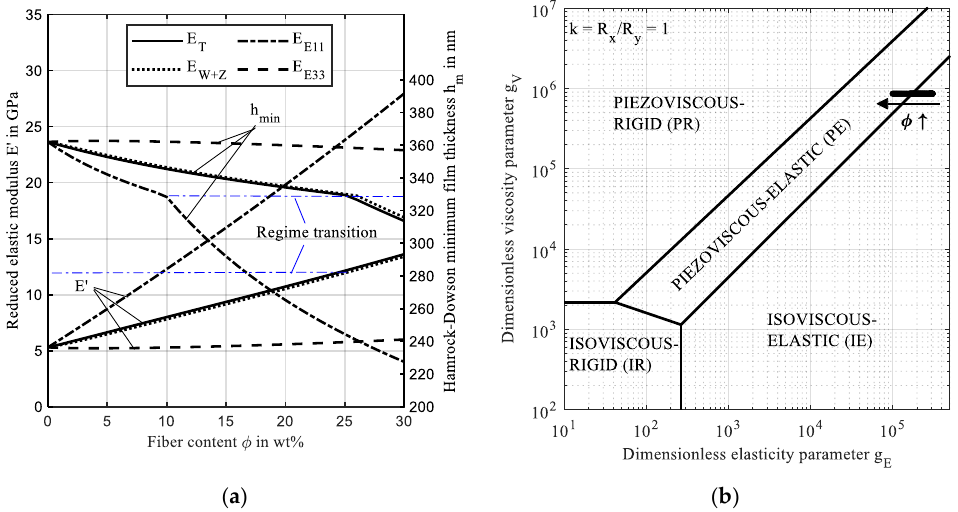
Figure 5. ( a ) Reduced elastic modulus E’ and minimum film thickness for the FRP effective elastic modulus models by Turner [10] ( 𝐸 𝑇 ), Wang and Zhang [15] ( 𝐸 𝑊+𝑍 ), Yang and Sun [12] ( 𝐸 𝐸11 ) and Tan and Sun [13] ( 𝐸 𝐸33 ) for variation of fiber content; ( b ) contact regime characterization of the investigated ball-on-flat contact in Johnson’s map [37], redrawn from [38].